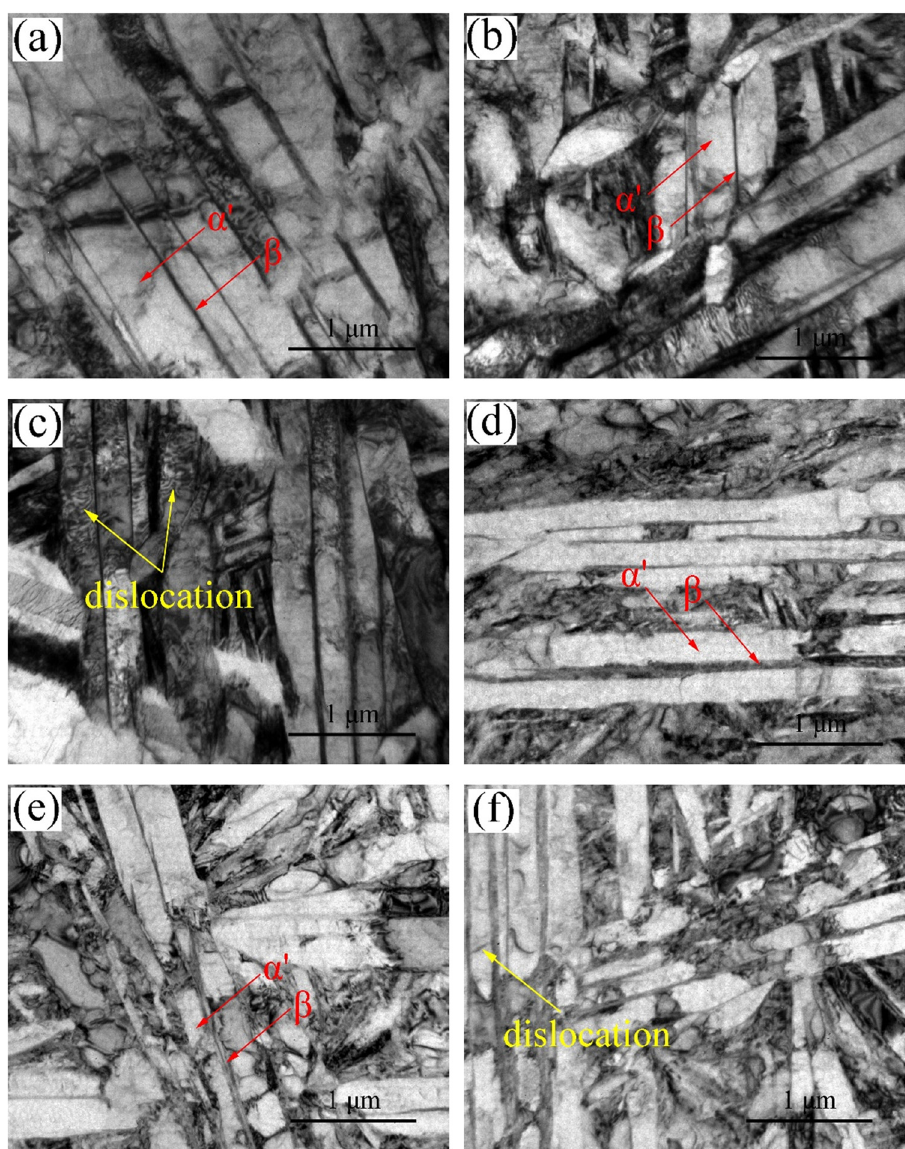
Figure 10: TEM images of FZ: ( a ) parallel aligned lath - like martensite in the FZ of EBW joint, ( b ) interlaced lath - like martensite in the FZ of EBW joint, ( c ) dislocations within lath - like martensite in the FZ of EBW joint, ( d ) parallel aligned lath - like martensite in the FZ of P - LBW joint, ( e ) interlaced lath - like martensite in the FZ of P - LBW joint, and ( f ) dislocations within lath - like martensite in the FZ of P - LBW